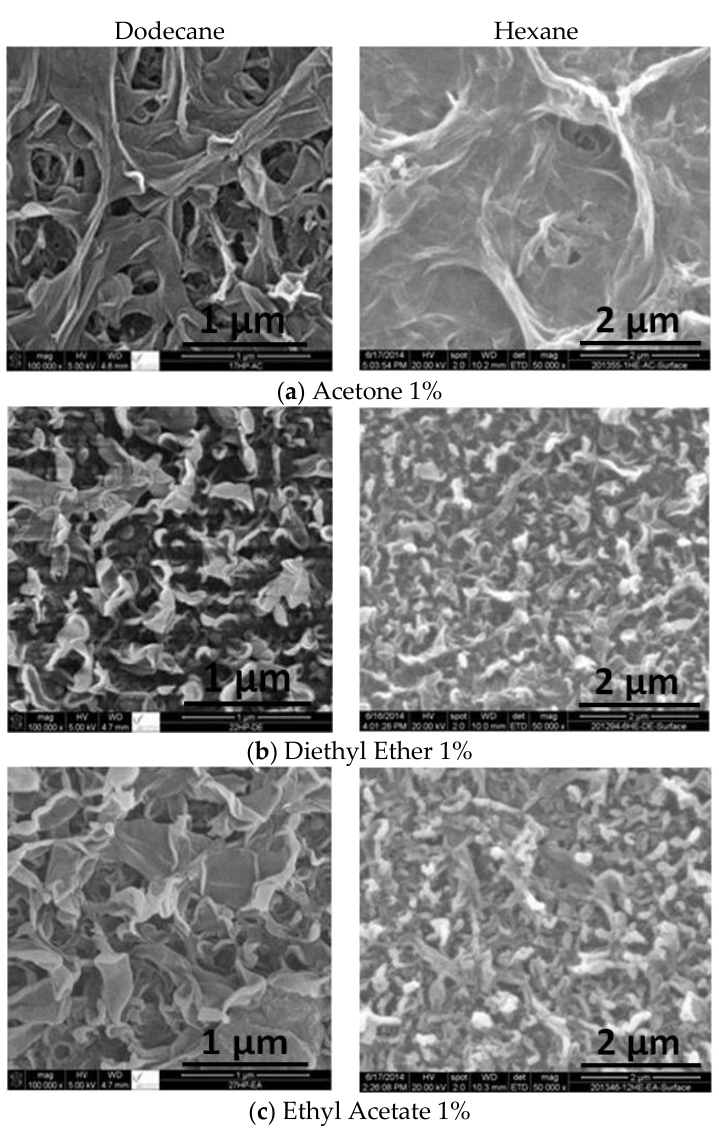
Figure 5. A comparison between dodecane (left) and hexane (right) on the morphology of the formulated membranes with 1% co-solvent concentration ( a ) acetone; ( b ) diethyl ether and ( c ) ethyl acetate.